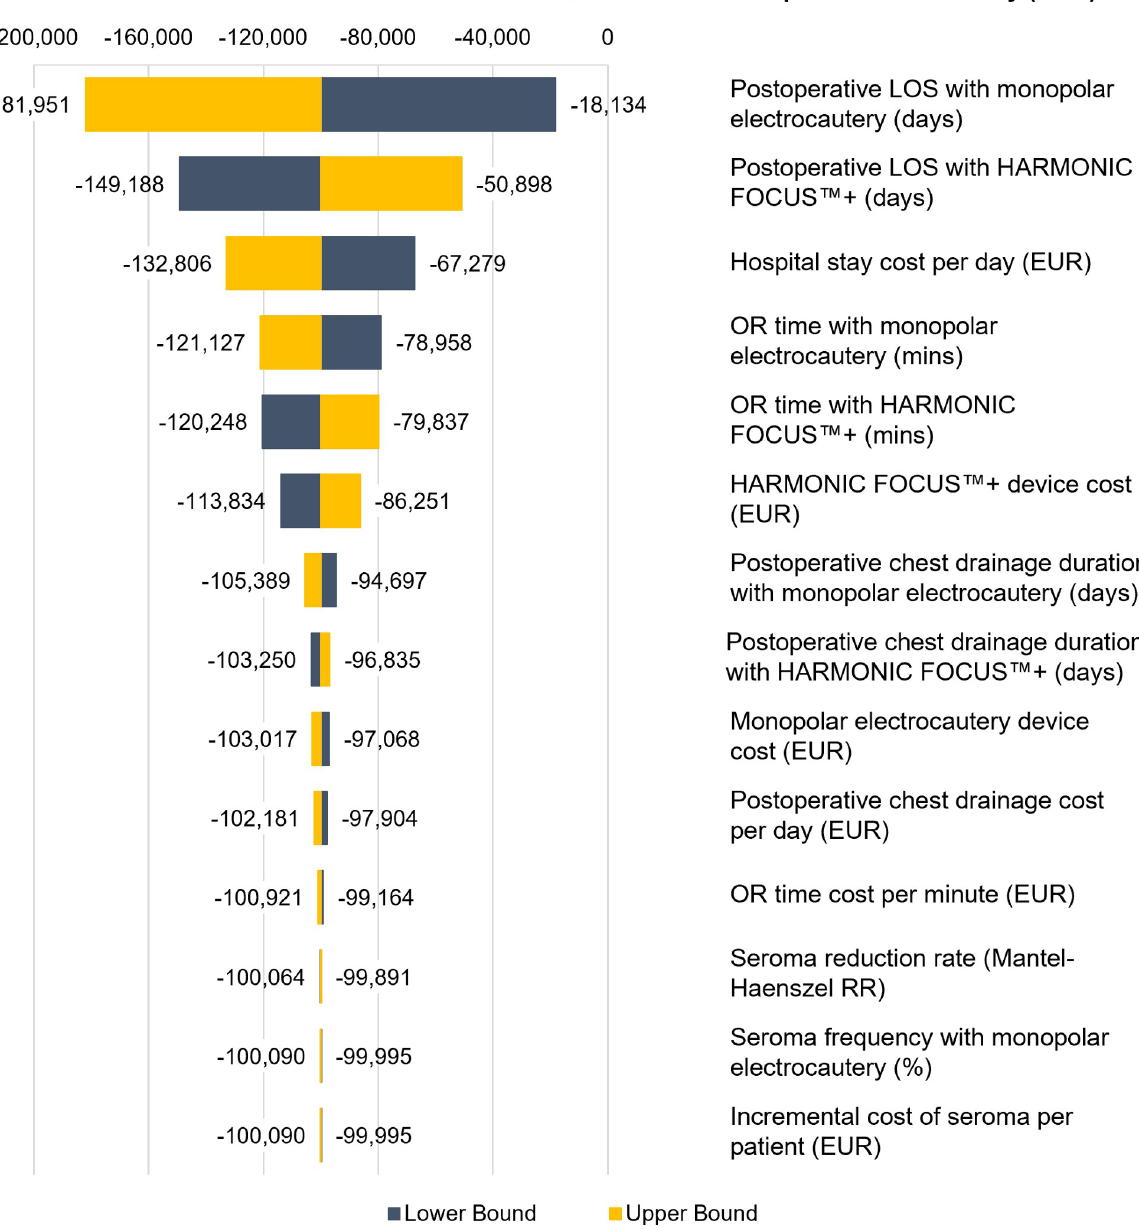
Fig 1. Tornado diagram of DSA results of the cost impact for the annual caseload. Negative values indicate cost saving with the intervention compared with the comparator. Abbreviations: DSA: deterministic sensitivity analysis; EUR: Euros; LOS: length of stay; OR: operating room; RR: risk